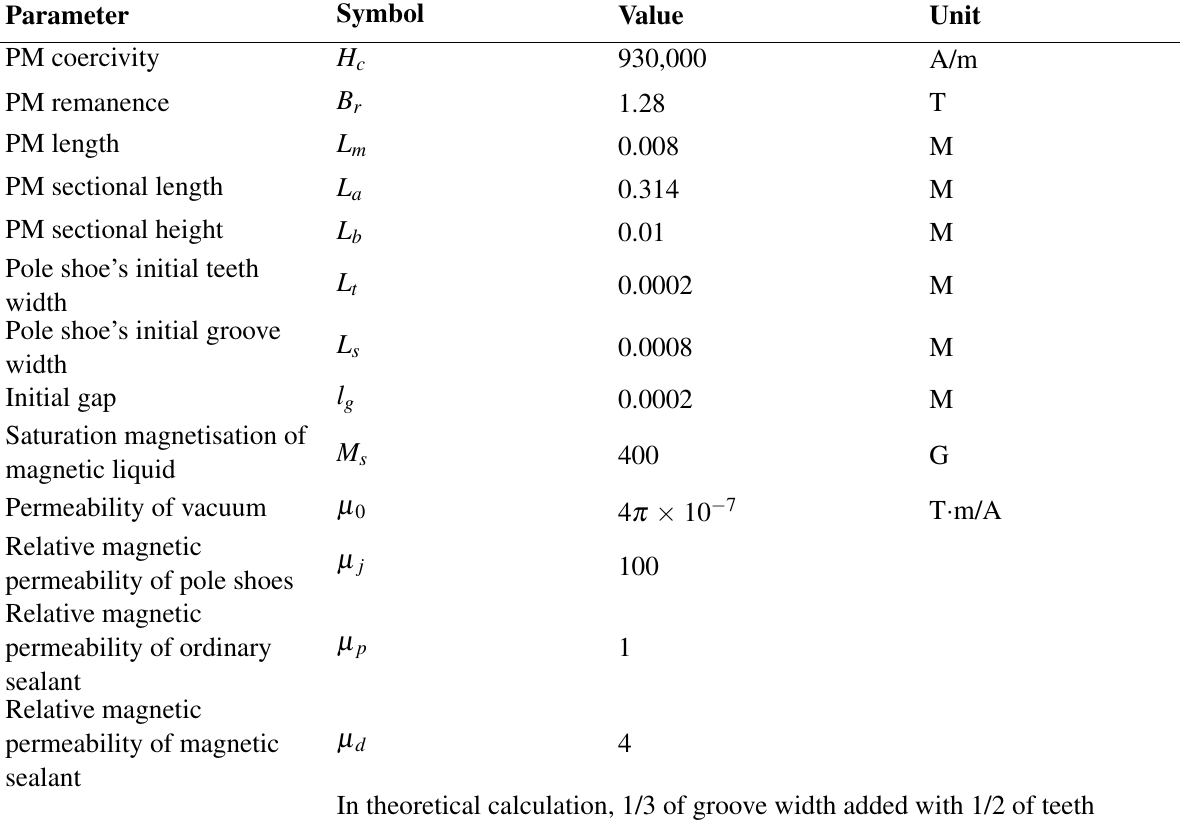
Table 1 The parameter table for calculating magnetic field intensity in the seal gap of split pole shoe structure.